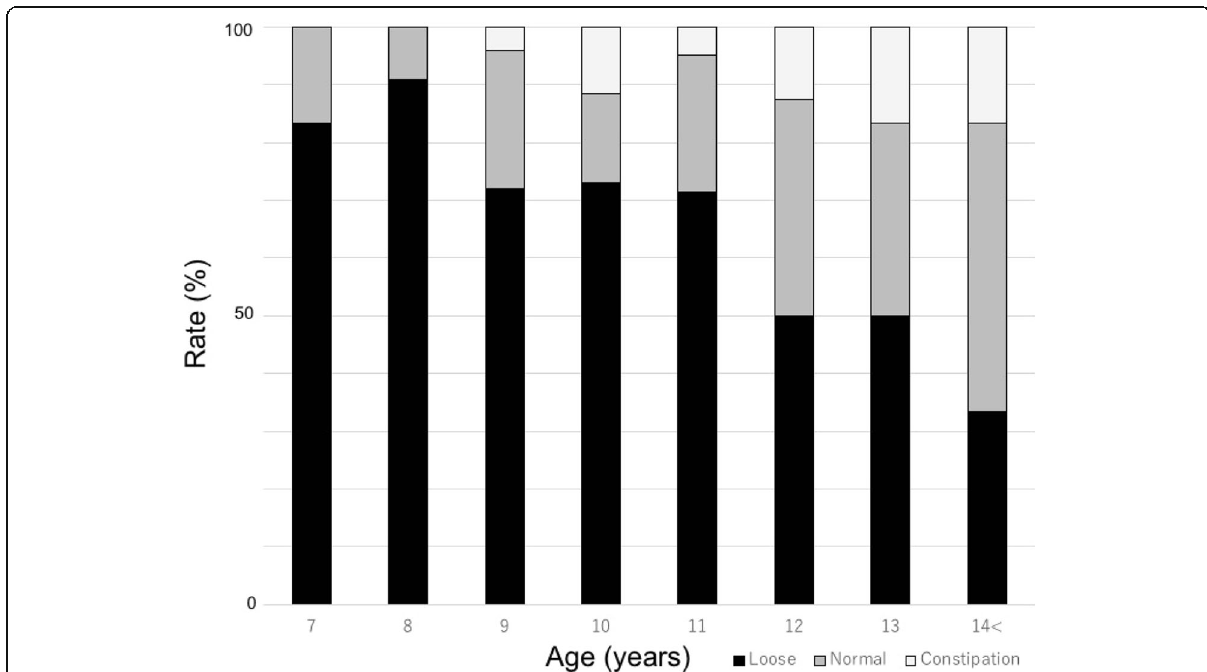
Fig. 1 Stool form evaluation results in age group. Stool form was initially evaluated using the Bristol stool chart, and subsequently, each stool form category (loose, normal, and constipation) was designated on the criteria mentioned in the materials